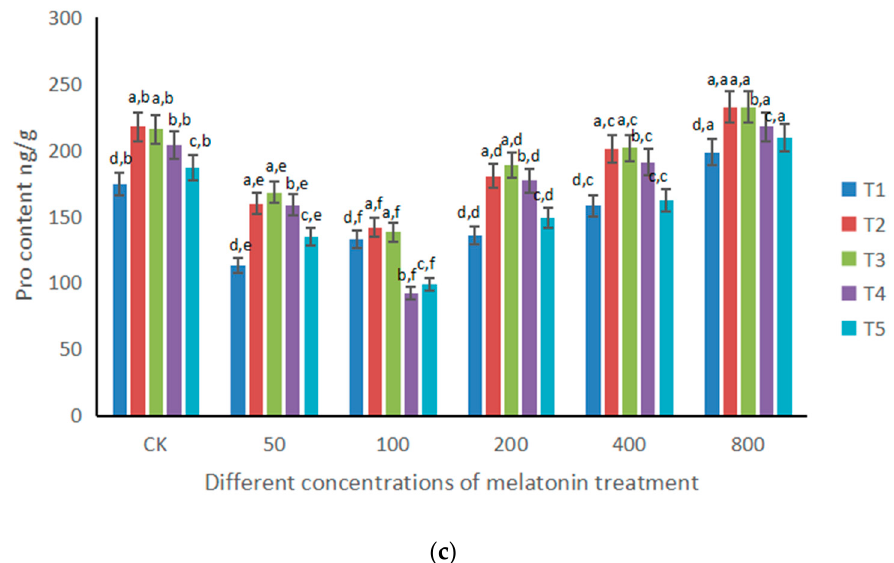
Figure 3. Relative soluble sugar, soluble protein, and proline content of Populus cathayana × canadansis ‘Xin lin 1’ leaves under control and different MT treatment based on salt and alkaline stress in different time periods of the experiment. T1 means 10 days, T2 means 14 days, T3 means 18 days, T4 means 22 days, T5 means 26 days. Each value is the average ± standard error (±SE). For two ‐ way ANOVA, the letters on the left represent the detection phase ( p < 0.05) and the letters on the right represent the experimental concentrations ( p < 0.05). ( a ) Changes of soluble sugar content, ( b ) changes of soluble protein content, ( c ) changes of proline content.